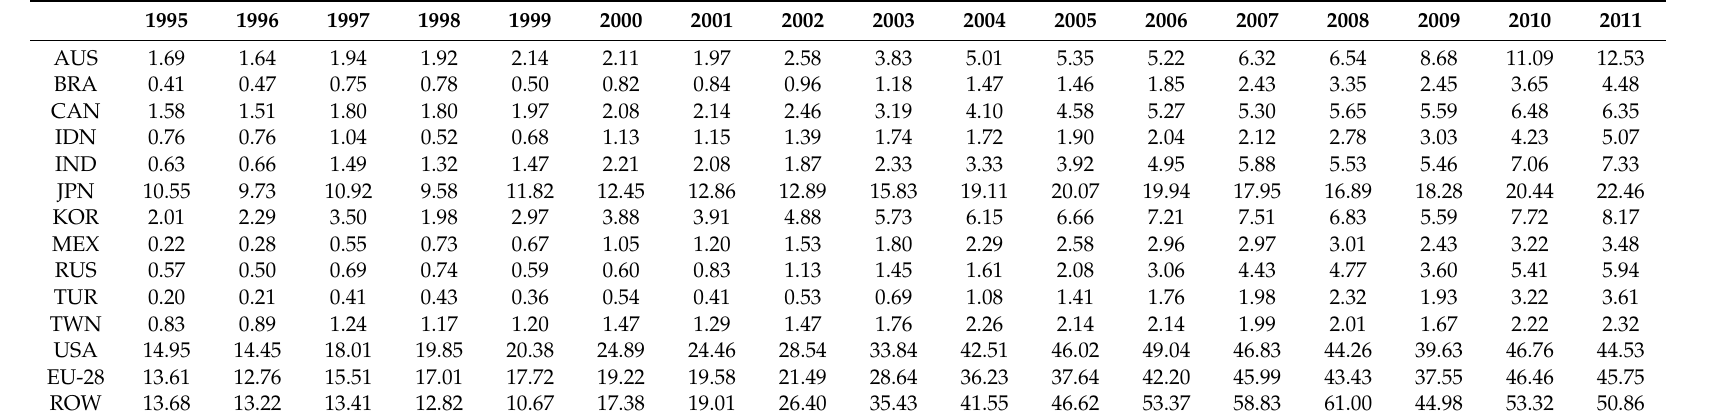
Table A2. China’s virtual oil exports (mtoe).